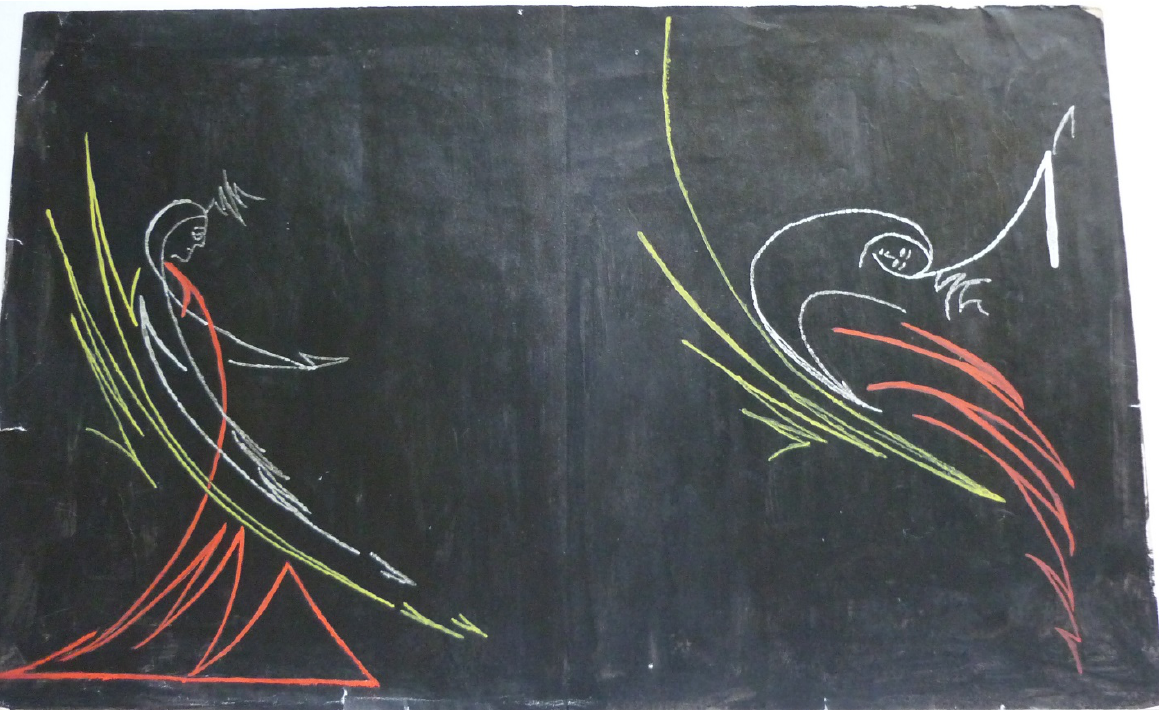
Figure 12. Bely’s drawing. 1913? Rudolf Steiner Nachlassverwaltung (Dornach).